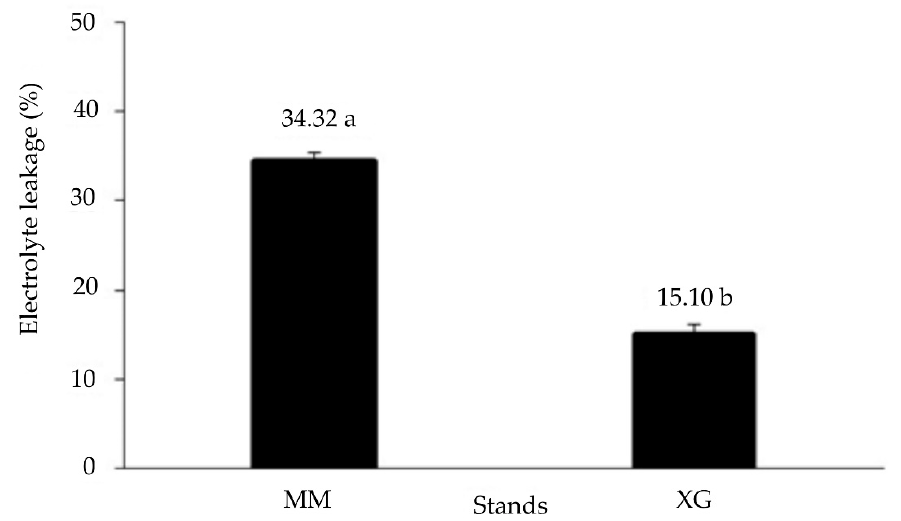
Figure 5. The leakage of electrolytes from the leaves of Filipendula vulgaris Moench collected from the areas of Molinia meadows (MM) and xerothermic grasslands (XG); mean values (n = 10, ± SD) marked with different letters a, b differ significantly according to Tukey’s test (for different N) at p ≤ 0.05.